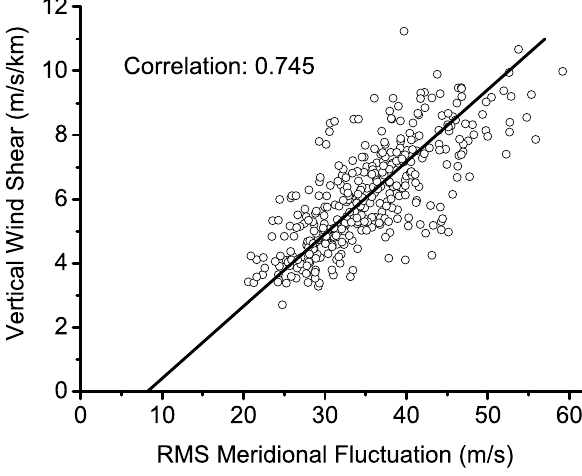
Fig. 9. As for Fig. 8, but height-integrated daily